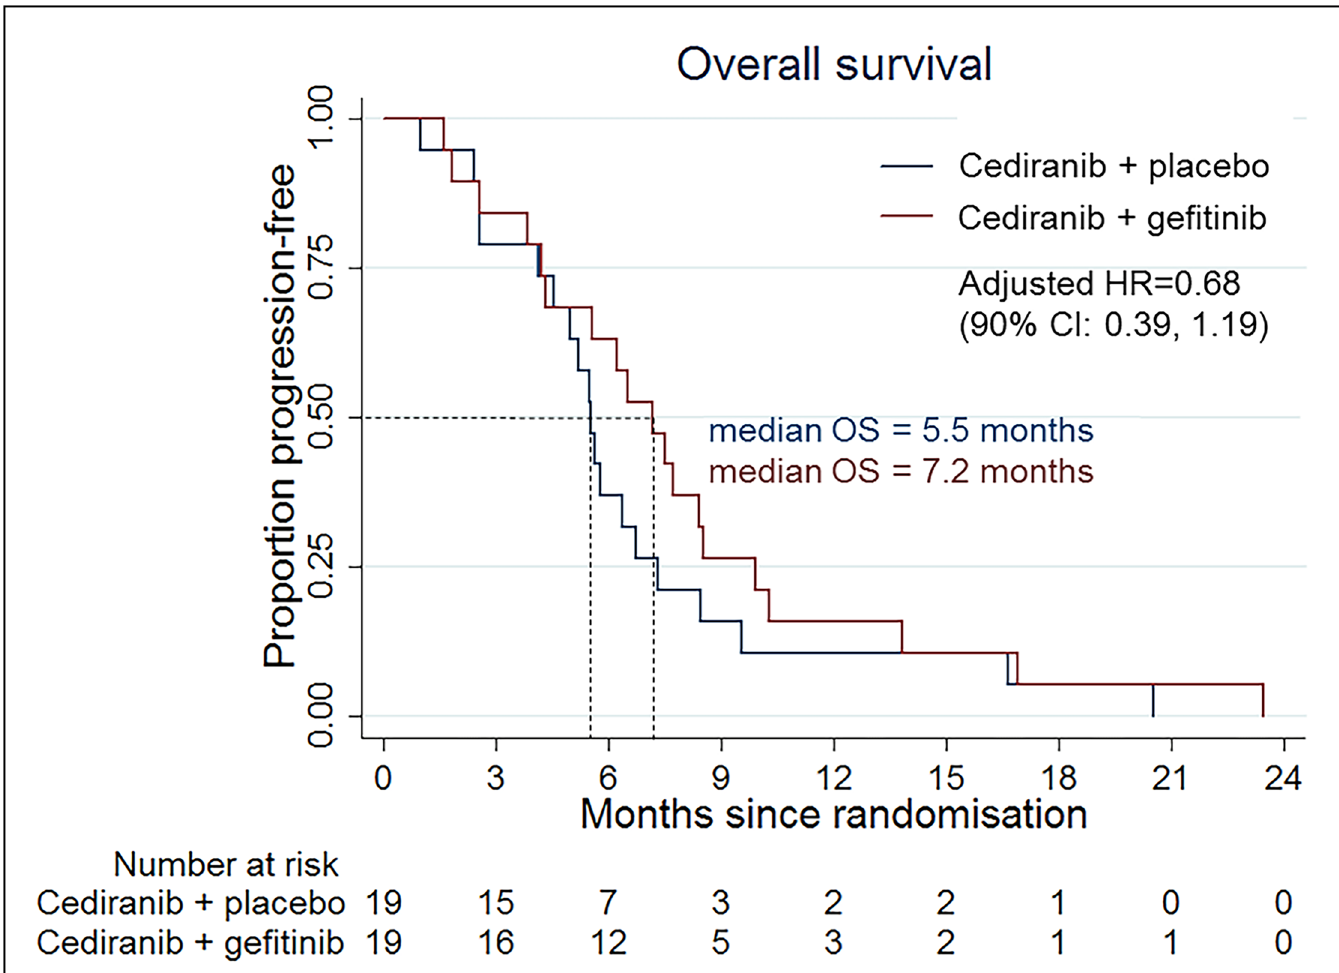
Fig 3. Kaplan-Meier plot for OS in the ITT